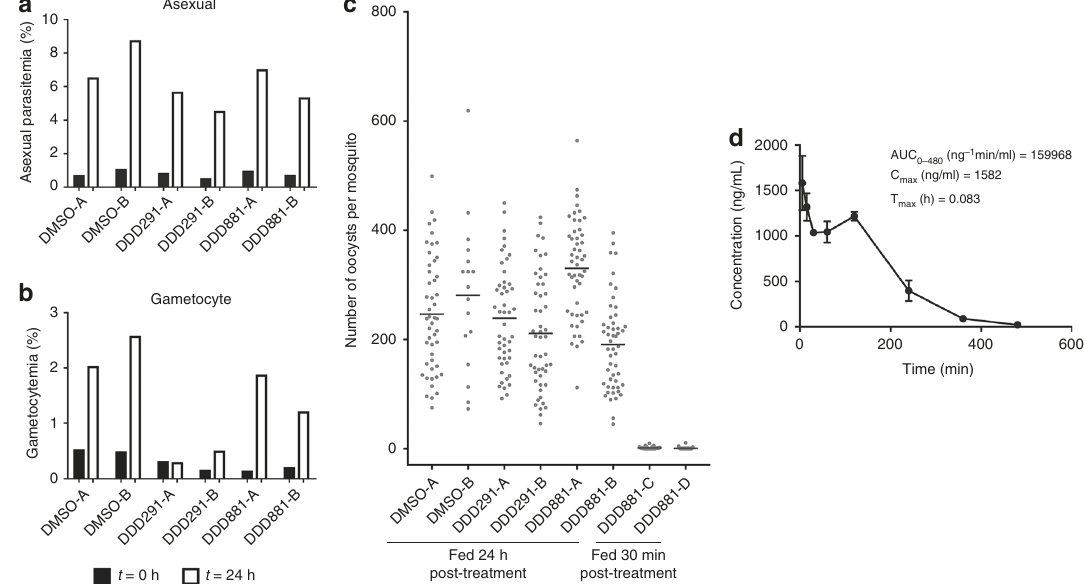
Fig. 9 In vivo transmission-blocking ef fi cacy in P. berghei direct feeding assays. Eight phenylhydrazine-treated mice were infected with P. berghei constitutively expressing GFP. On day 3 of infection, they were assigned into four groups of two mice (DMSO A + B; DDD291 A + B; DDD881 A + B